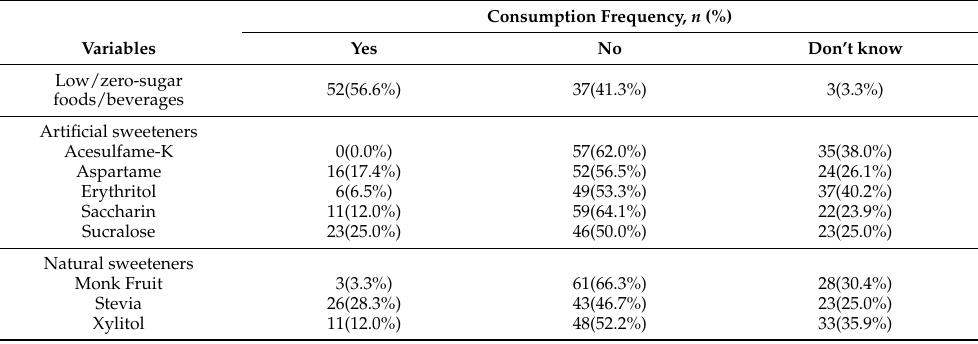
Table 5. Consumption of low/zero-sugar products and zero-calorie sweeteners by consumer panel (at least once a month) ( n = 92).